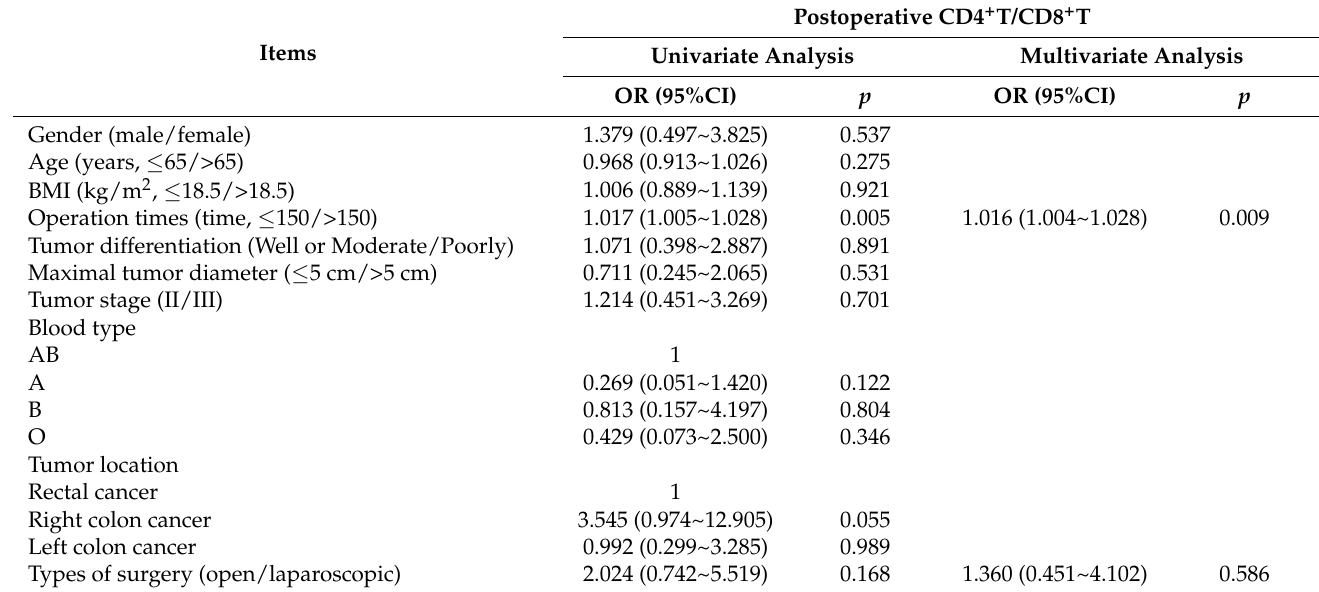
Table 6. Logistic regression analysis of the patient’s postoperative CD4 + T/CD8 +